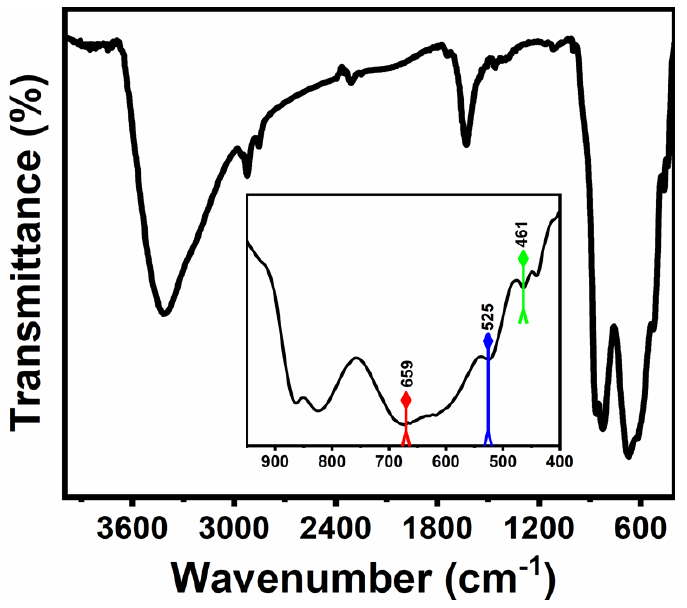
Figure 2. FT-IR spectrum of the calcined Ni-CoWO 4